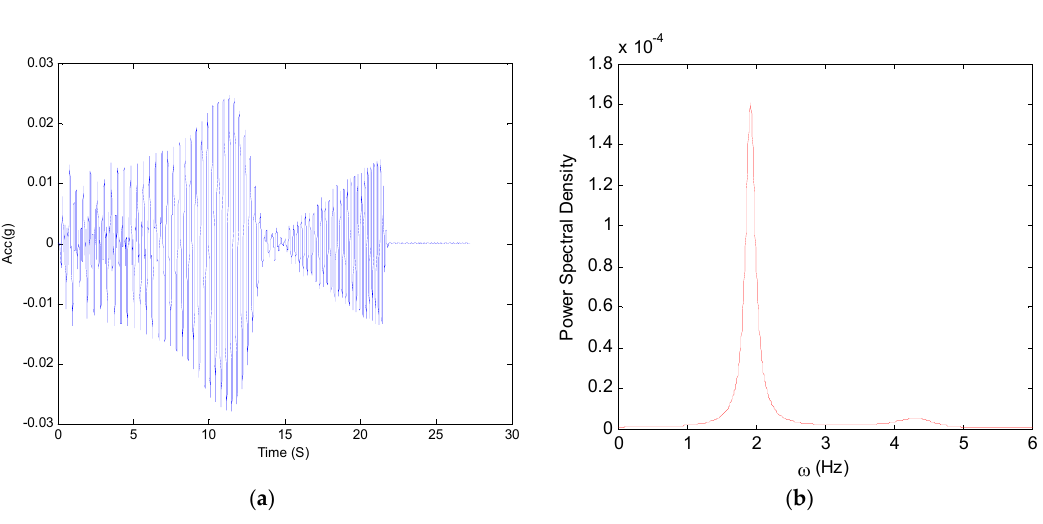
( c ) Figure 6. ( a , b ) Structural responses for TMD 1.80 and 2.39 kg of uncontrolled and controlled structure behaviors; and ( c ) frequency contents of output measurements.